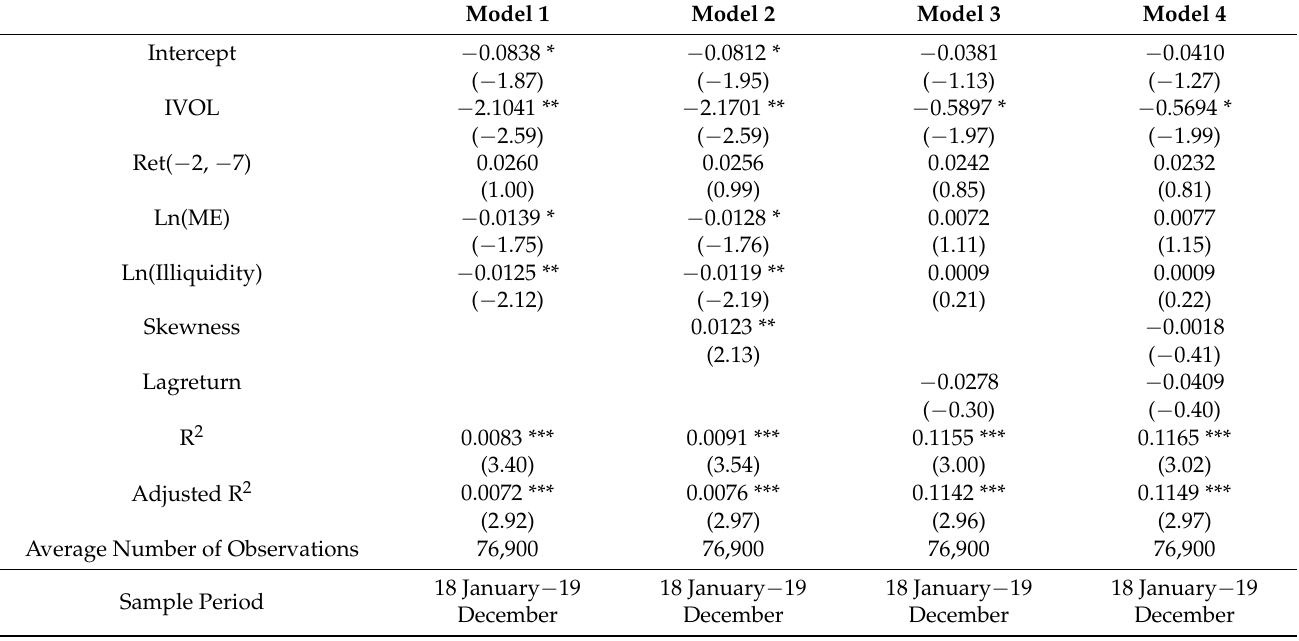
Table 3. Cross-sectional analysis before the